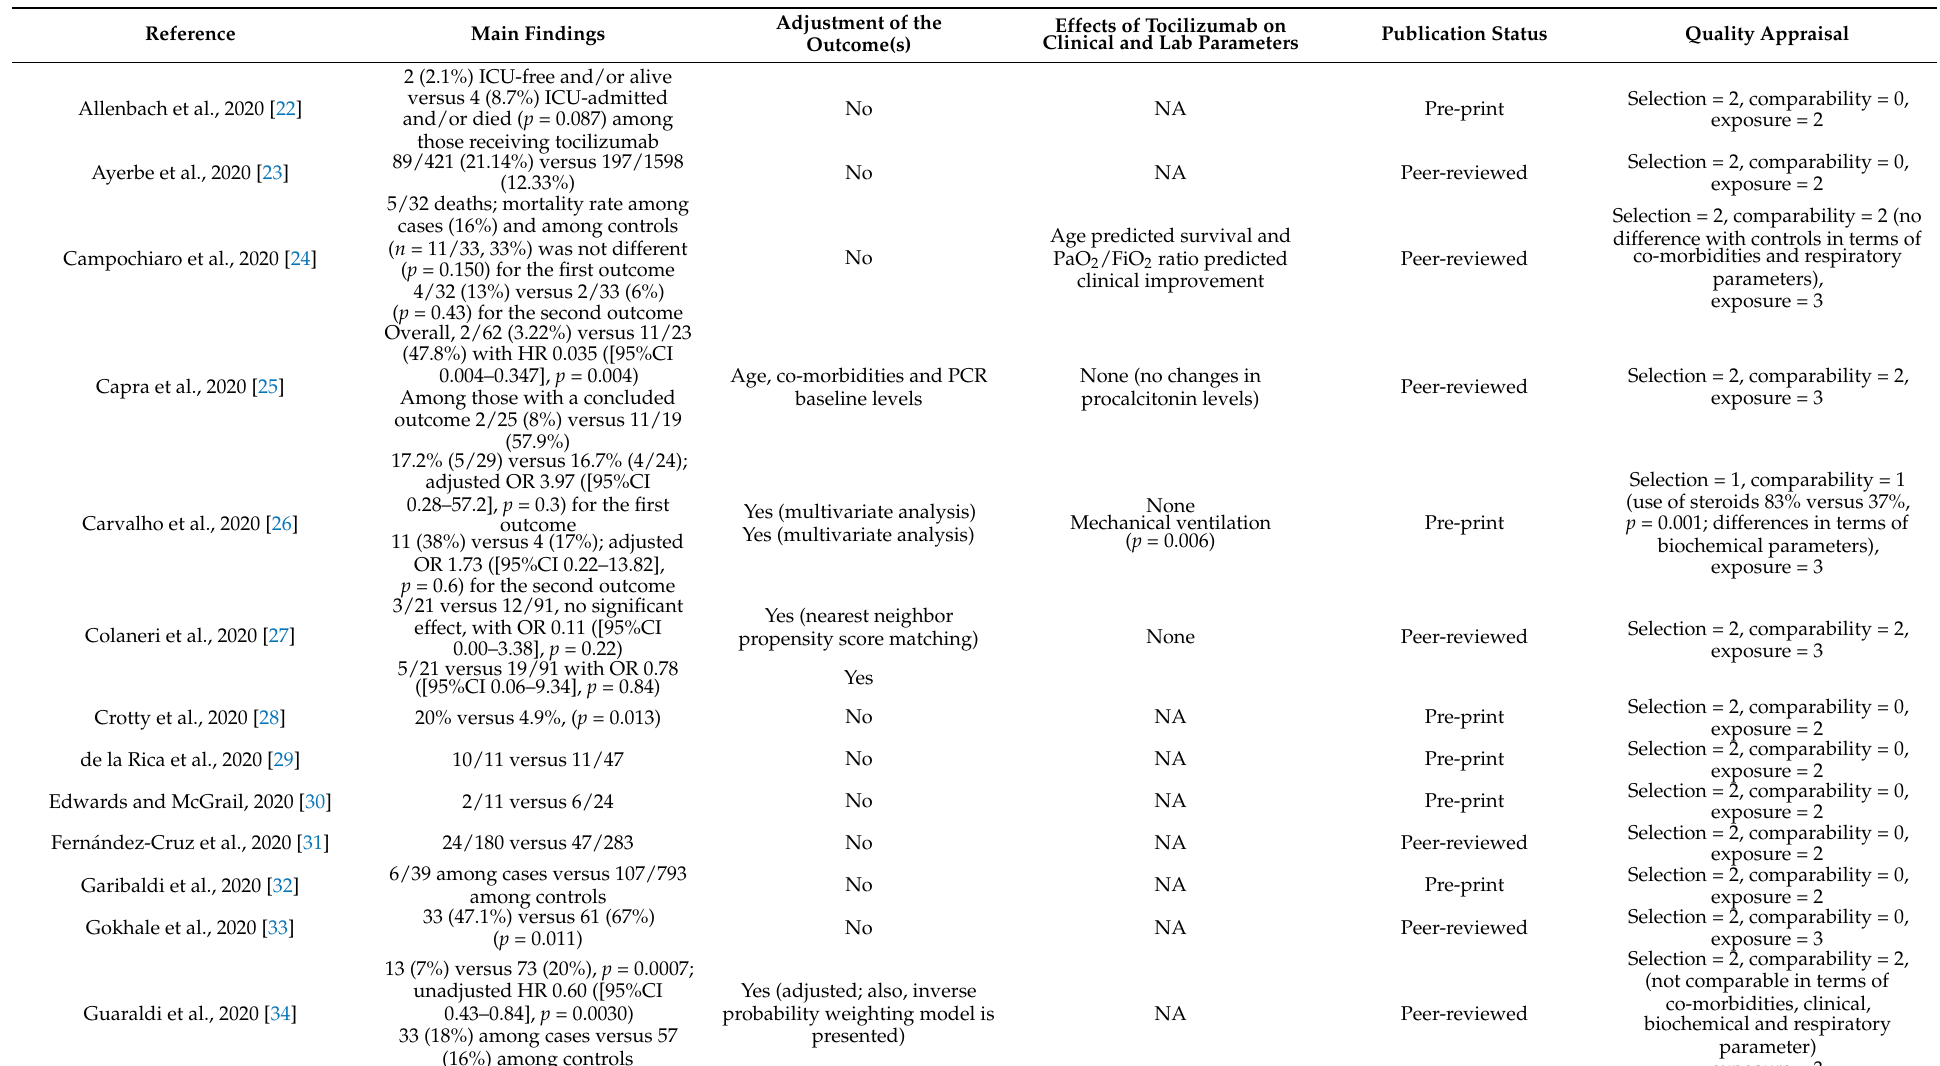
Table 3. Main findings and quality assessment of included